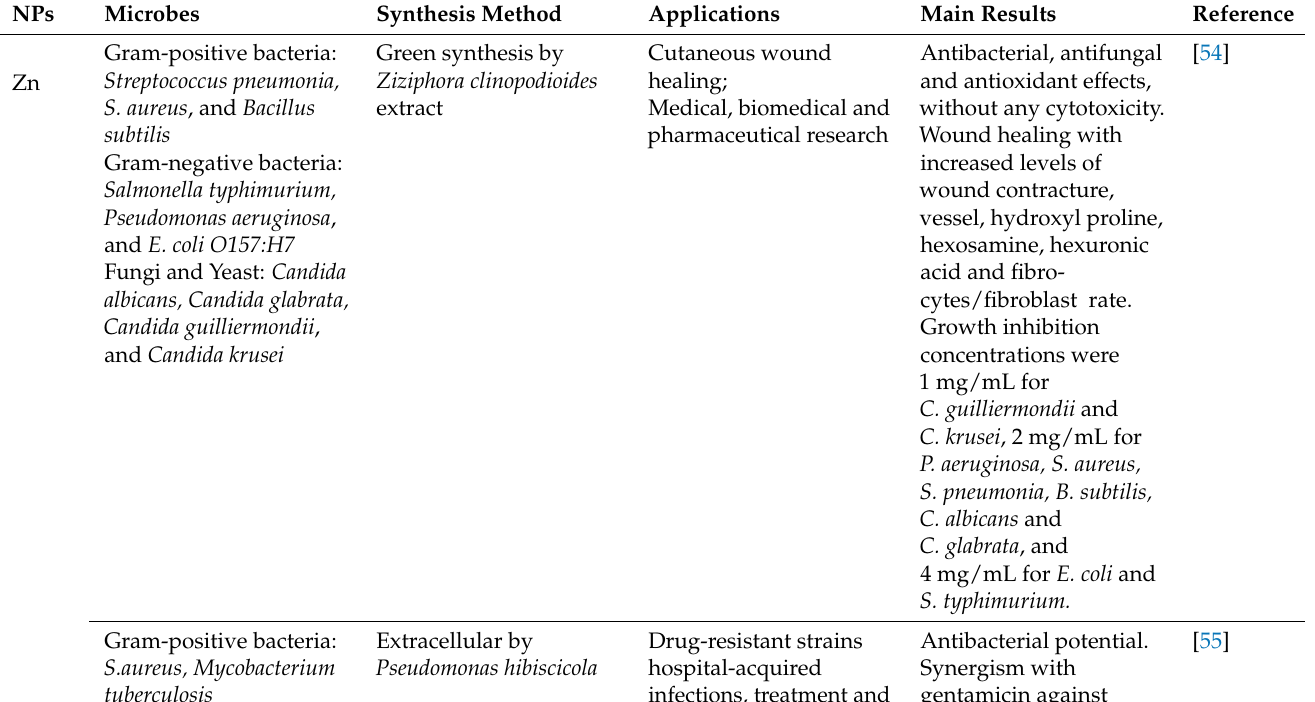
Table 2. Summary of some experiments regarding the antimicrobial action of M-NPs against different